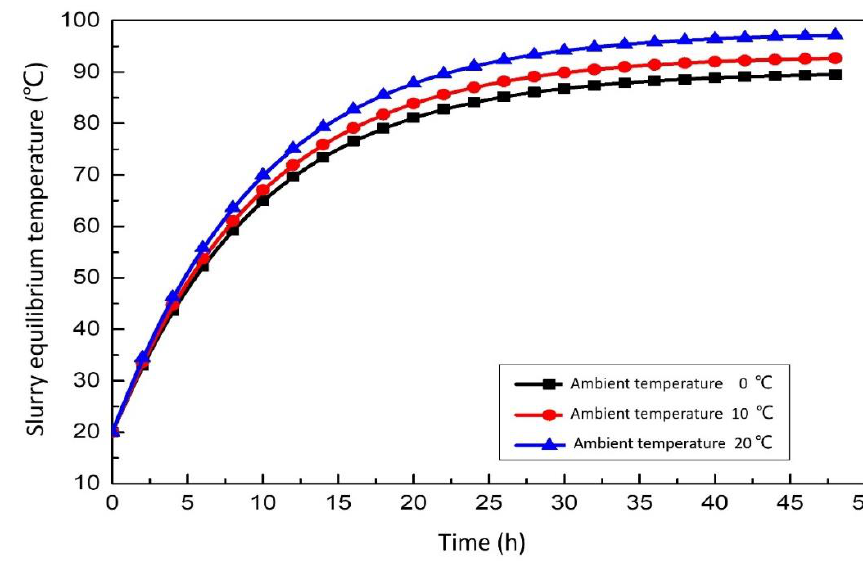
Figure 9. Effect of ambient temperature on the slurry equilibrium